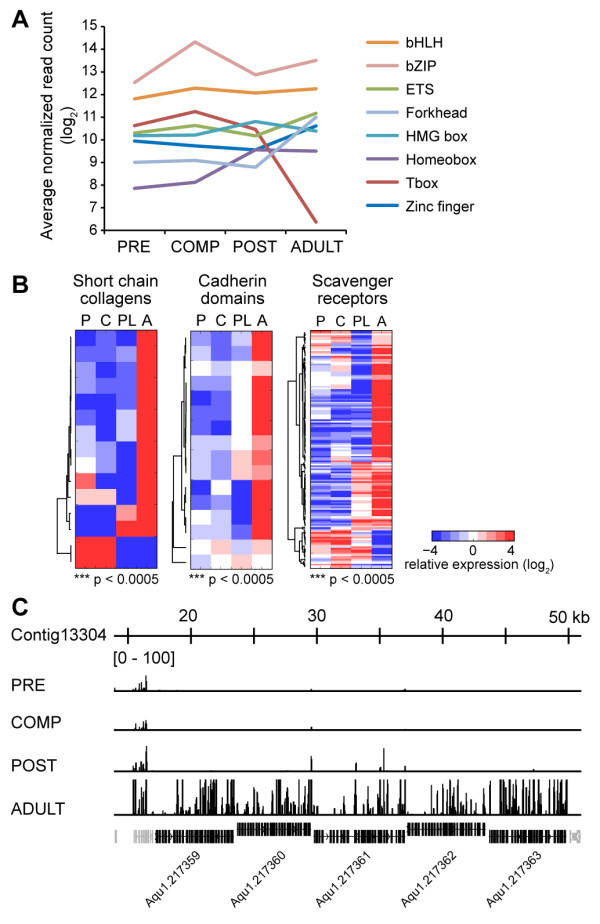
Expression of transcription factors. (A) Average normalized read counts for members of transcription factor families at four stages of A. queenslandica development. Genes were retrieved from previous studies [23,56,57]. (B) Gene families exhibiting coordinated gene expression. Short chain collagens, cadherin domain-containing, and scavenger receptor domain-containing gene families show specific upregulation at the adult stage. Heat maps show the relative expression of these genes across development (red, high; blue, low). Stage enrichment of genes was estimated using Fisher’s exact test (p-values shown). (C) Cluster of 5 scavenger receptor domain-containing genes that are expressed in the adult sponge. Reads mapping to this genomic locus in the different developmental stages are shown (reads normalized to 10 million, maximum peak height shown is 100 reads). Non-scavenger receptor genes in the cluster are shown in gray.